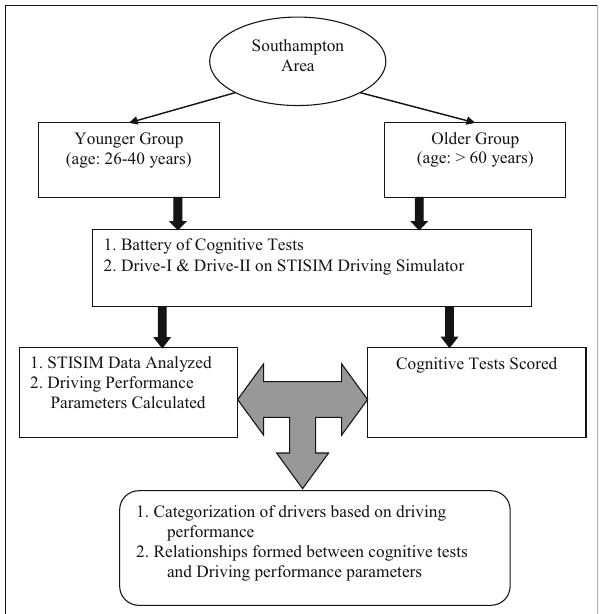
Fig. 1 Schematic diagram showing the methodology of